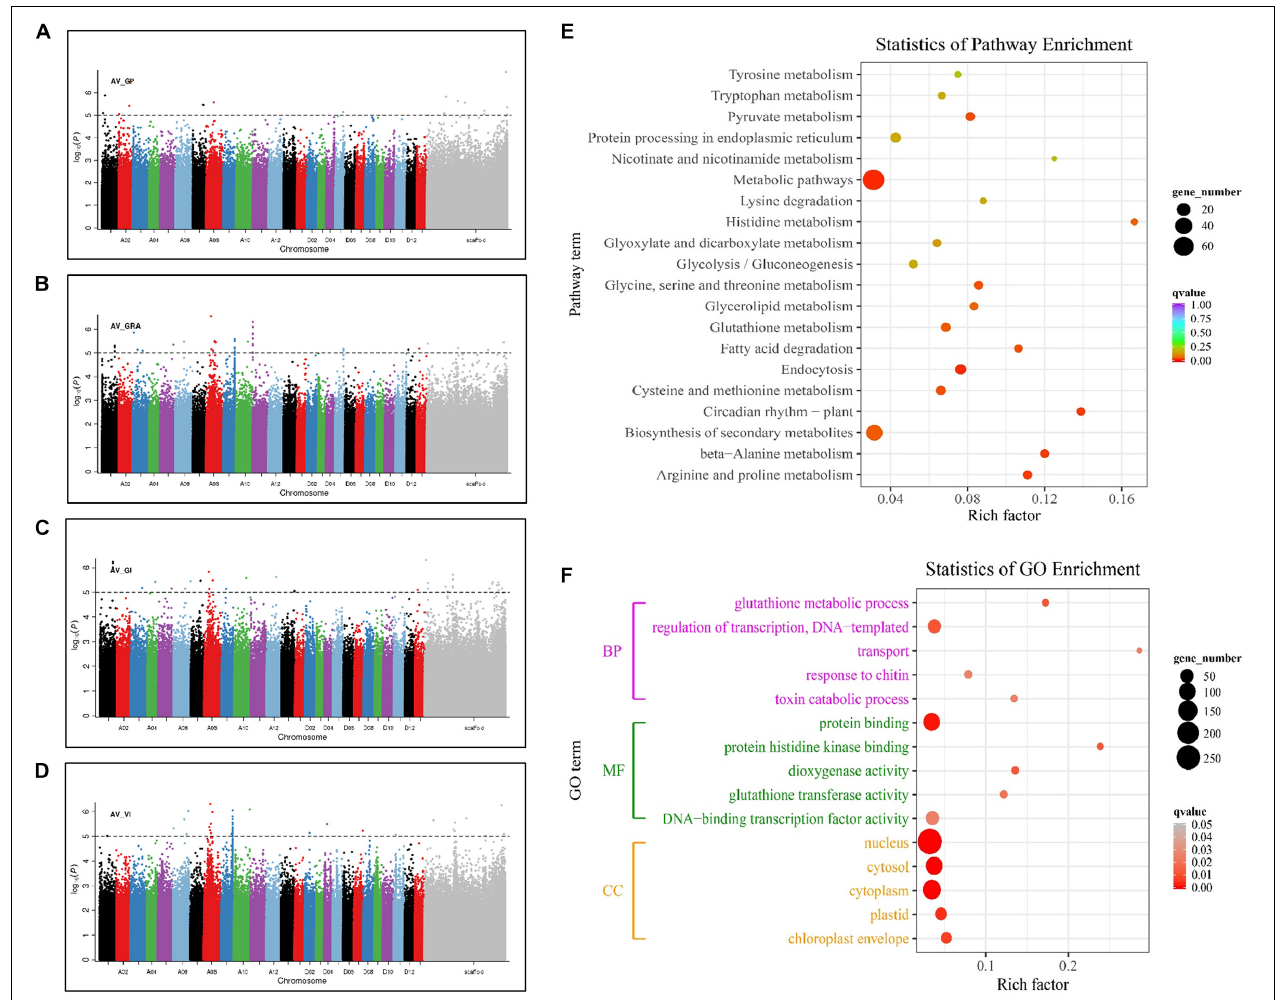
FIGURE 2 | Manhattan plots of the four seed germination-related traits and GO function and KEGG pathway enrichment of candidate genes. (A) GP. (B) GRA. (C) GI. (D) VI. (E) Statistics of KEGG pathway enrichment analysis of 723 genes detected in GWAS. (F) Gene Ontology (GO) functional enrichment analysis of 723 genes detected in GWAS. Each point in the figure represents a GO channel, and the channel name is shown on the left axis. The abscissa is the enrichment factor, which represents the ratio of the proportion of proteins annotated to this pathway in the differentially expressed protein to the proportion of proteins that are annotated to a pathway of the species protein. The larger the enrichment factor, the more reliable the significance of the enrichment of differential proteins in this